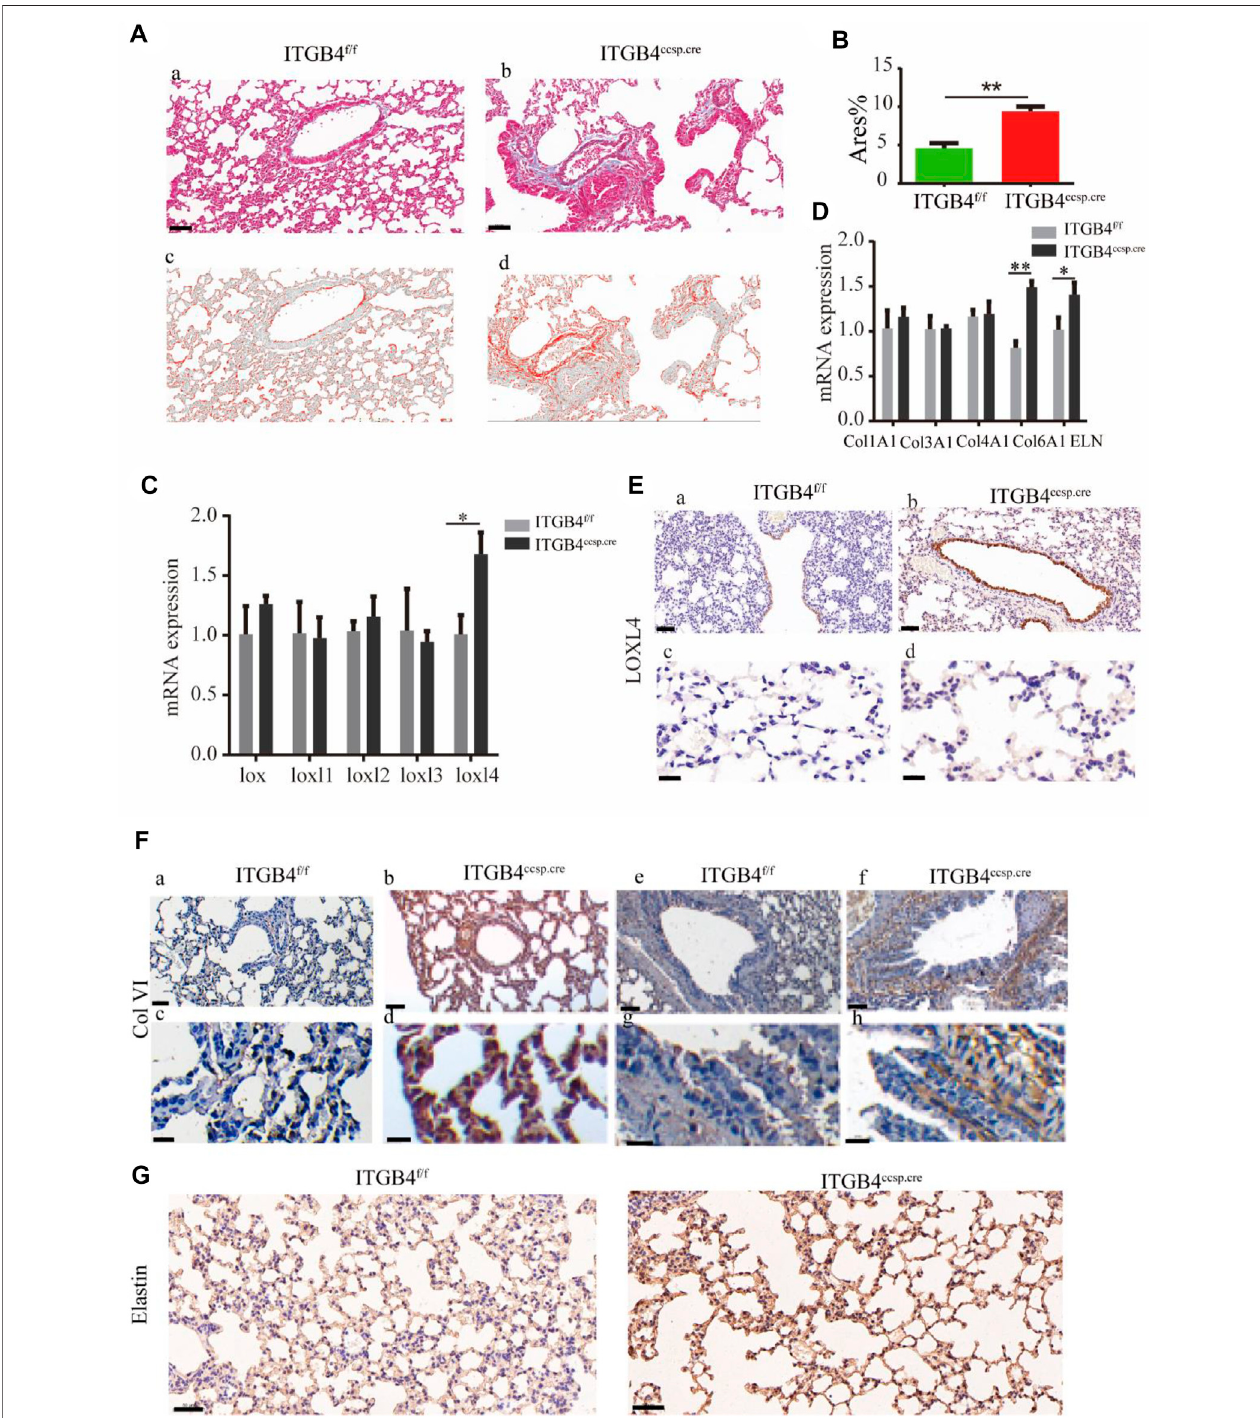
FIGURE 3 | The expression of collagens, elastin and LOXs between ITGB4 f/f and ITGB4 ccsp.cre mice. (A,B) Masson ’ s Trichrome stain image (a, b) and ImageJ Imaging Software-generated image (c, d) to calculate Area % of collagen (Red). Scale bars: 50 μ m. (C,D) The mRNA expression levels of collagens, elastin and LOXs were detected by RT-PCR. (E) Immunostaining for LOXL4 in airway epithelium (a,b) and alveolar septa (c,d) in ITGB4 f/f and ITGB4 ccsp.cre lungs. Scale bars: 50 μ m for (a, b);20 μ mfor(c,d). (F) ImmunostainingforCOLVIinpulmonaryalveoli(a – d)andinairwayepithelium(e – h)inITGB4 f/f andITGB4 ccsp.cre lungs.Scalebars:200 μ mfor (a, b, e, f); 50 μ m for (c, d, g, h). (G) Immunostaining for elastin in pulmonary alveoli. Scale bars: 20 μ m. ( n = 3 independent experiments, * p < 0.05, ** p < 0.01). Data are presented as mean ± SD.